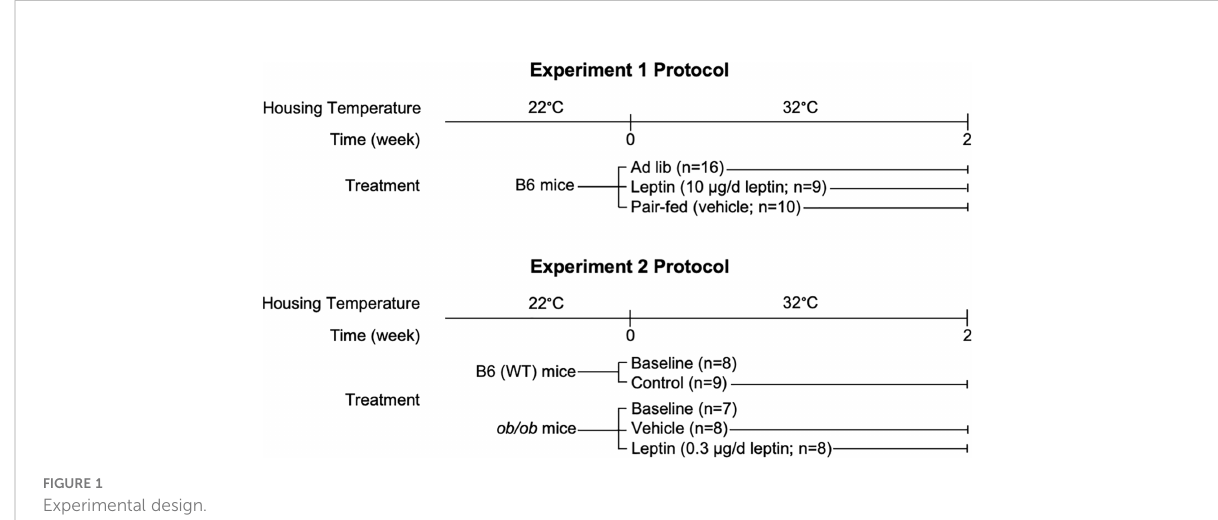
FIGURE 1 Experimental